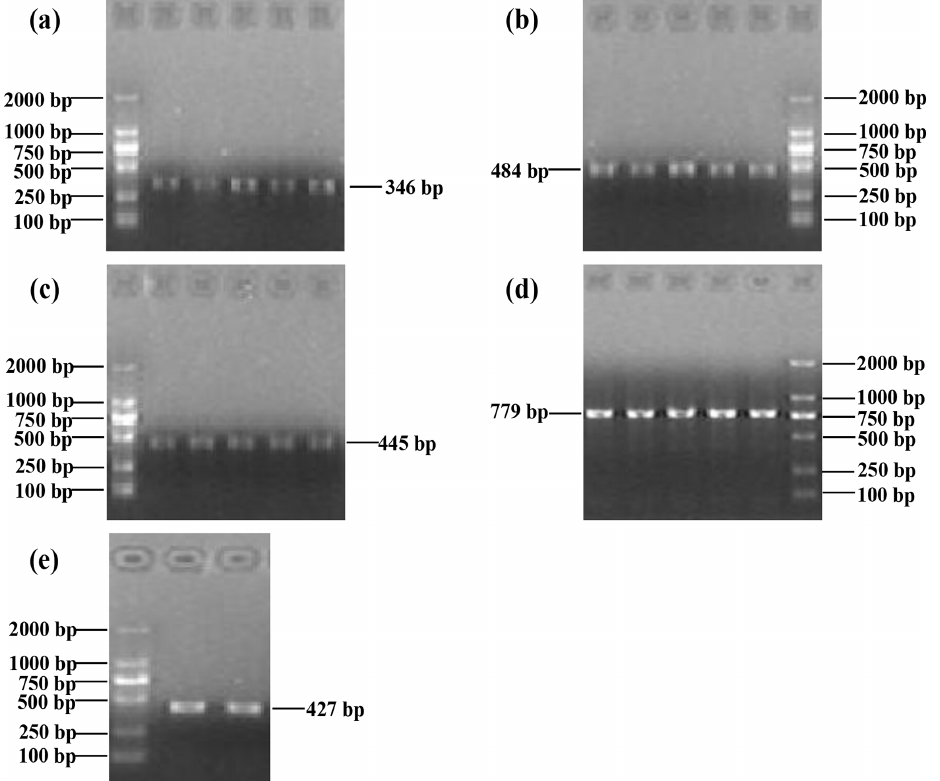
Figure 1. Five PCR-amplified fragments of buffalo CSN3 detected by agarose gel electrophoresis, covering exon I (a) , exon II (b) , exon III (c) , exon IV (d) and exon V (e) in